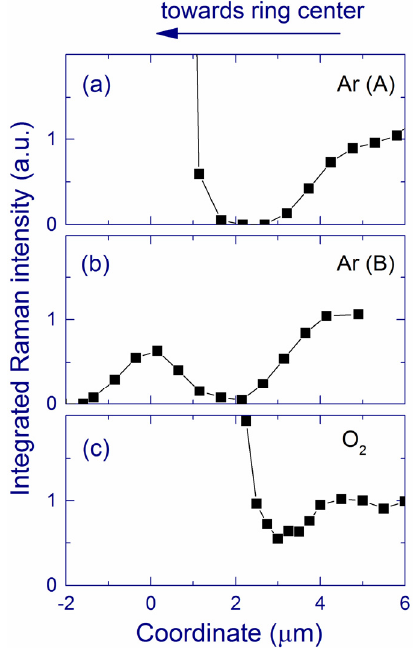
Figure 16. Characteristic Raman cross-sections of the ring region. Two characteristic cross-sections ( a ) and ( b ) are shown for Ar atmosphere, and the cross-sections ( c ) are similar for O 2 . For air, the cross-sections are similar to the case of O 2 . The Raman signal is integrated in the 230–585 cm –1 range. The data are normalized by the Raman intensity measured from the pristine film. Reprinted with permission from [142]. Copyright 2014, American Scientific